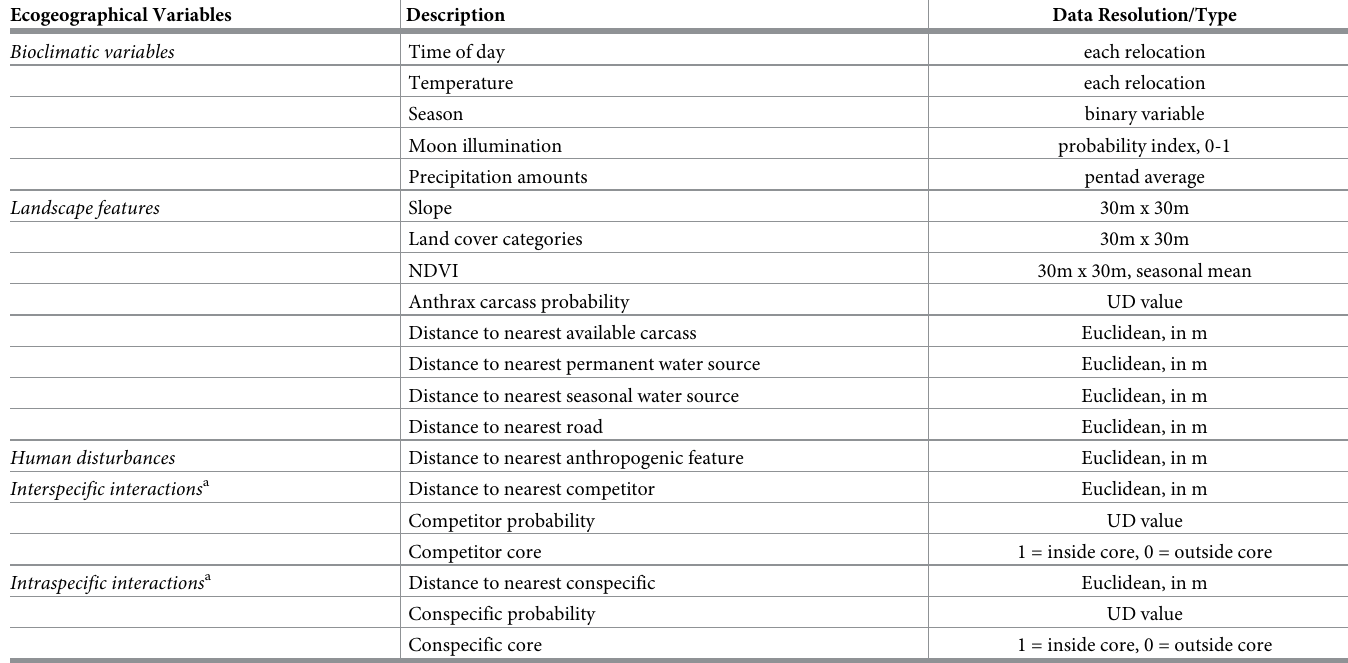
Table 2. Description of ecogeographical variables (EGVs) used for cluster